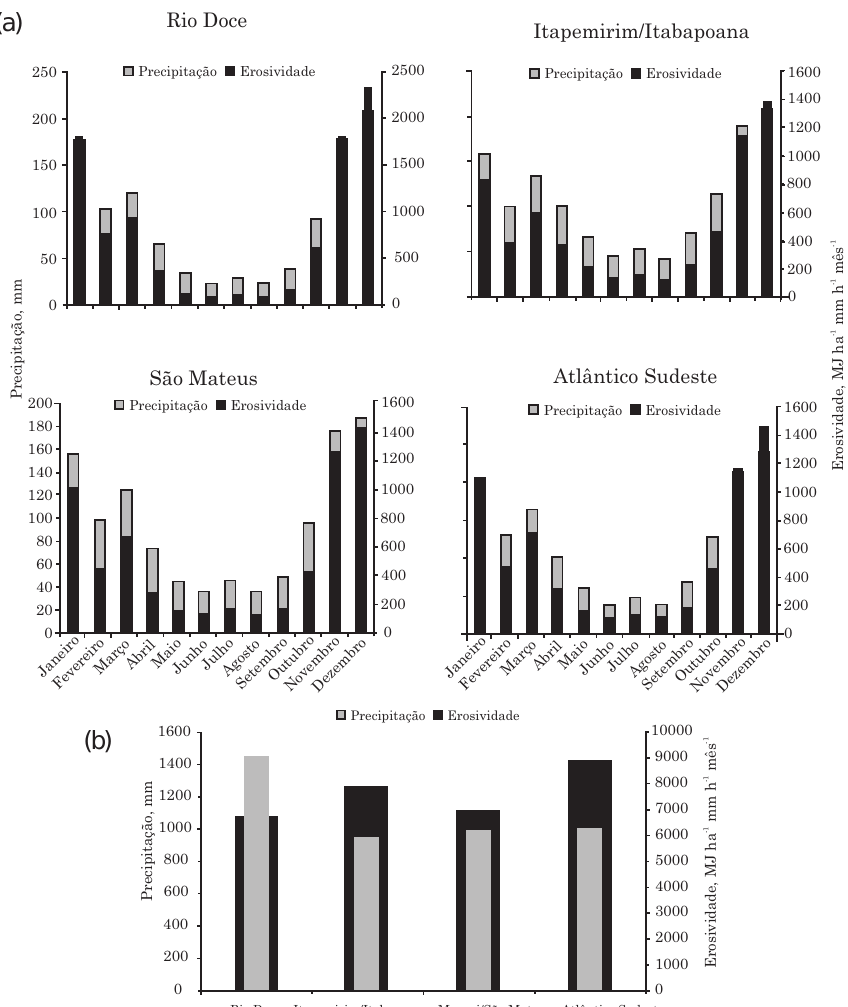
Figura 2. Distribuição média mensal (a) e anual (b) da precipitação e erosividade da chuva para as quatro regiões do Estado do Espírito Santo consideradas neste